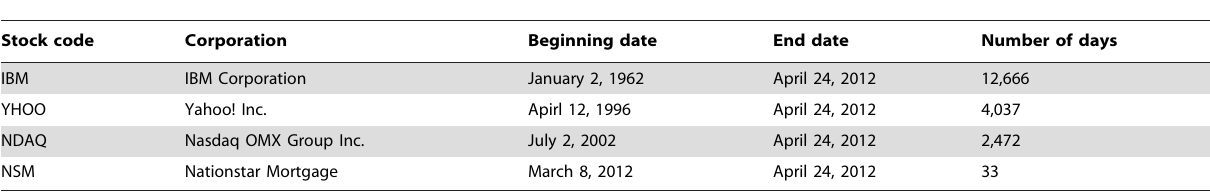
Table 1. Samples of the analyzed database of the S&P 500 stocks.